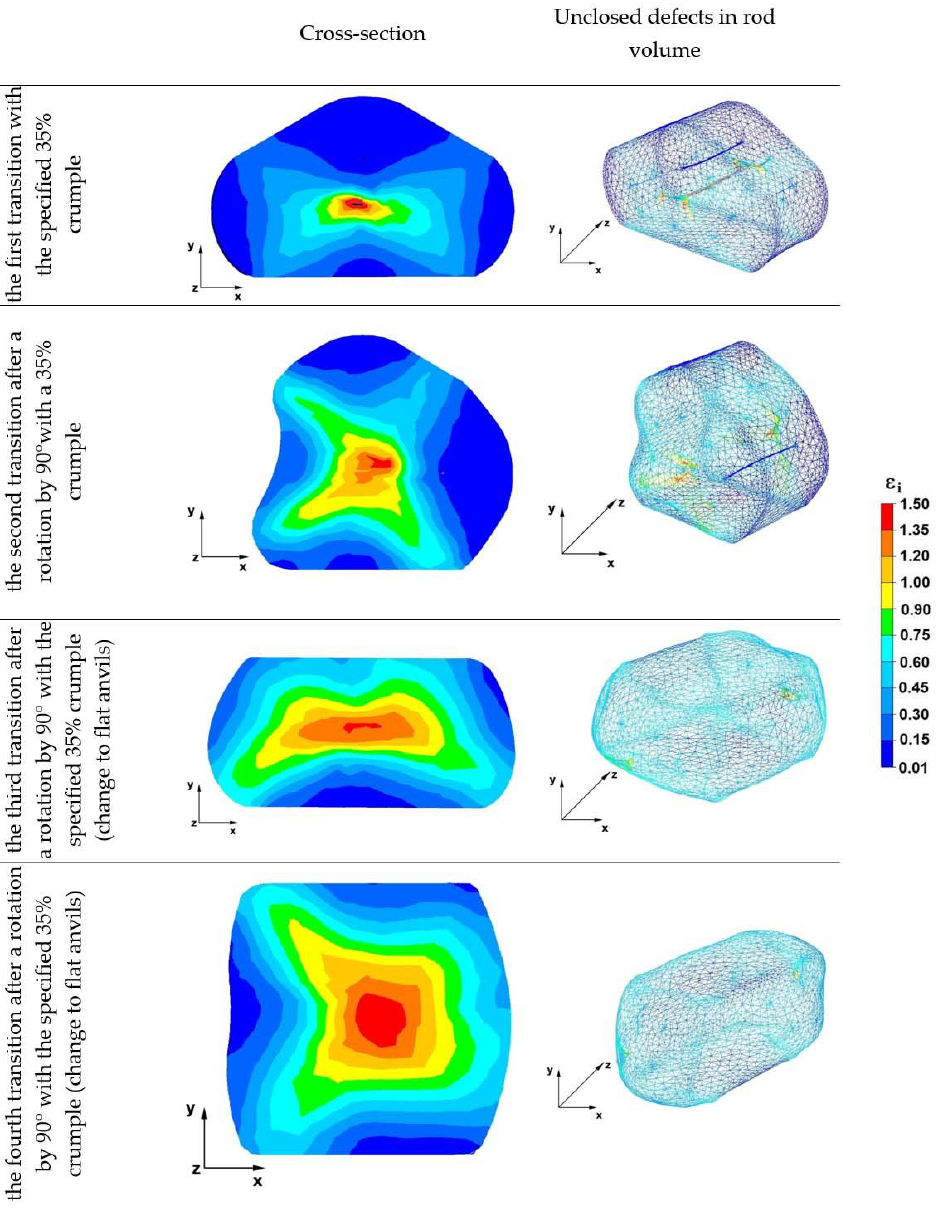
Figure 12. Effective strain distribution in rhombic flat anvils.